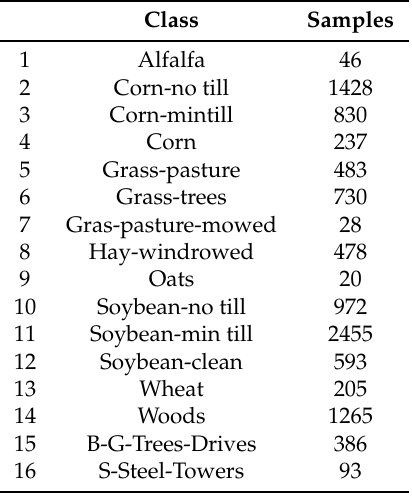
Table 1. The ground category and sample number of AVIRIS image data.